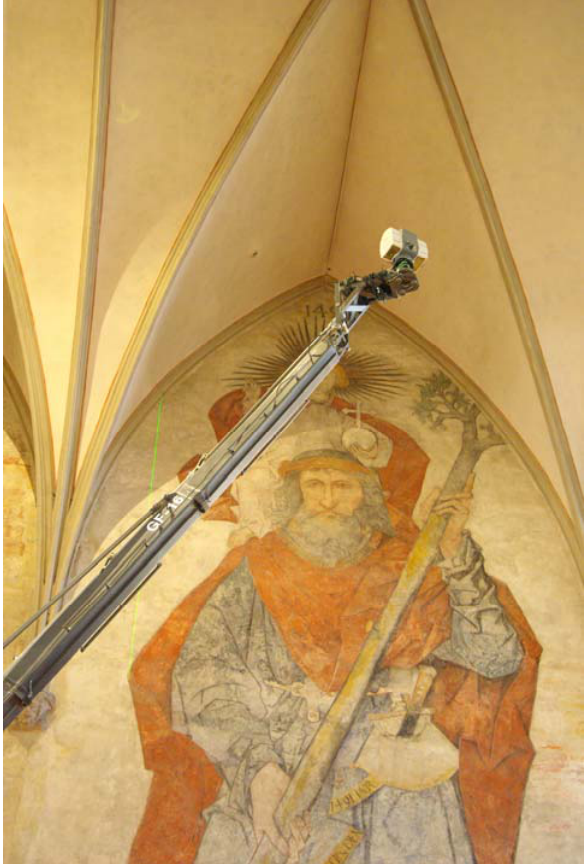
Picture 12. LEICA Scanstation of GF16 ©by